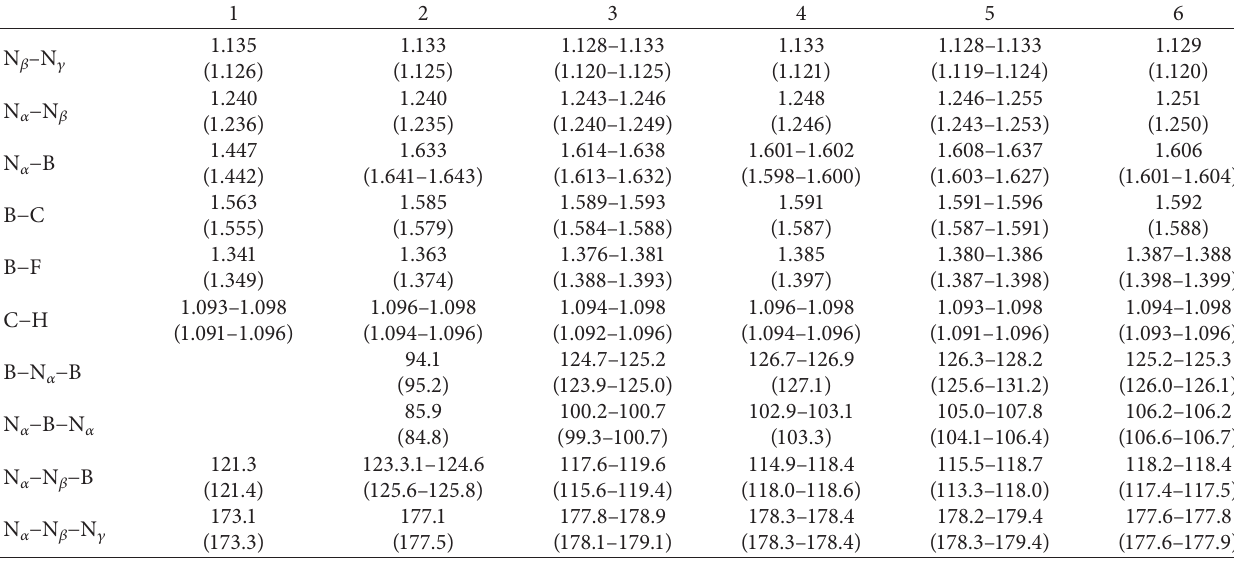
Table 1: Ranges of the bond lengths (˚A) and bond angles (deg) for the most stable structures of the asymmetric clusters (CH ( n � 1– 6) optimized at the DFT-B3LYP level a